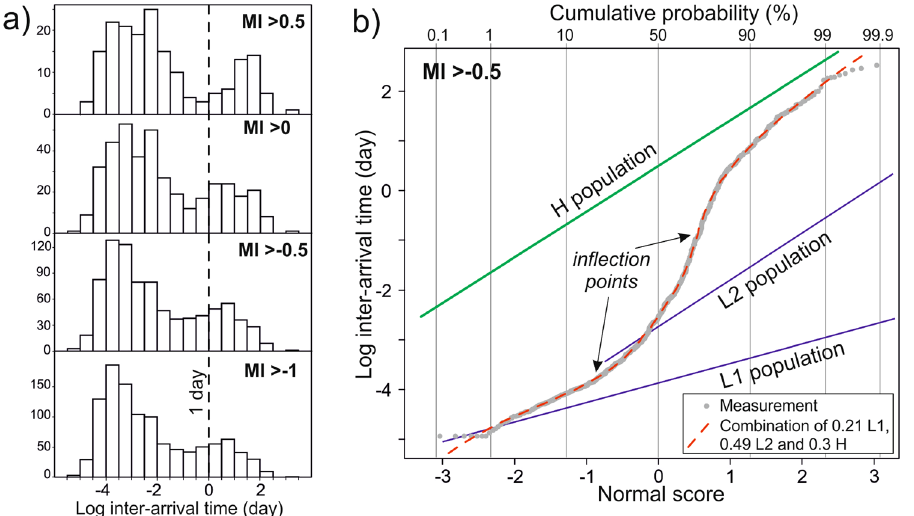
Figure 2. ( a ) Histograms of the log inter-arrival time of Campi Flegrei VT events for different magnitudes. ( b ) Probability plot of log inter-arrival times and partition of the distribution in swarm events (populations L1 and L2) and background events (population H).